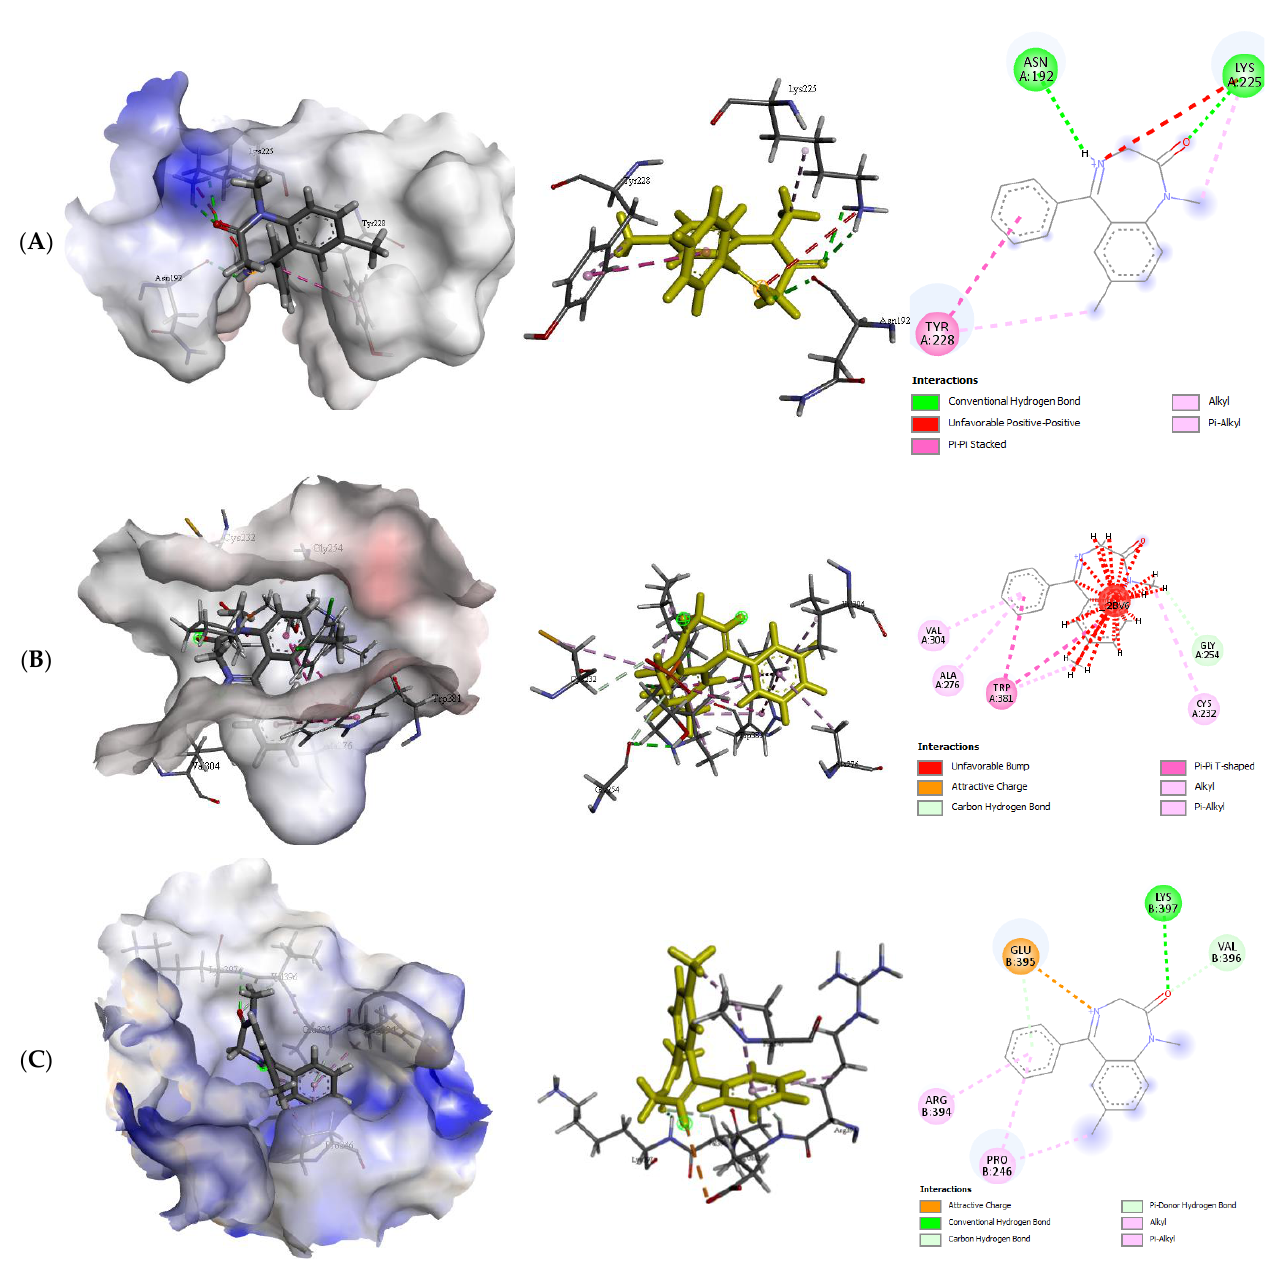
Figure 4. The 2D and 3D structure of molecular docking interactions of (A) GABA (α5), ( B ) GABA (β1), and ( C ) GABA (β2) receptor with diazepam (DZP). Eventually, FLU binds to GABA receptor subunits α 5, β 1, and β 2 with − 6.0, − 6.4, and − 7.9 kcal/mol, respectively, through two carbon–hydrogen bonds and one pi–pi bond, respectively, with Asn278, Tyr228, and Ser 279. FLU may attach to the GABA α 5 subunit. Furthermore, FLU interacts with GABA β 1 subunit through two H-bonds with Ser233 (2.25 Å) and pi–pi and pi–alkyl bonds with Trp168 and Trp381. Additionally, FLU interacts with GABA β 2 subunit through two H-bonds with Cys690 (2.55 Å) and Tyr620 (2.55 Å), one carbon–hydrogen bond with Ser691, and six pi–alkyl bonds with Ala526, Cys662, and ILE68 (Table 7). Figure 5 depicts the 2D and 3D structures of QUR non-bond interactions with GABA receptor